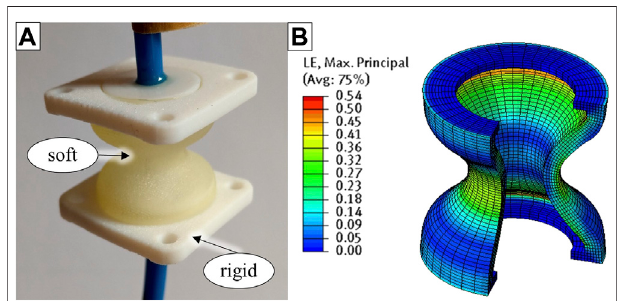
FIGURE8| Structuralsimulationofabellowsrelaxation experiment. The inkjet-printed specimens consist of rigid top and bottom fl anges and a soft bellows structure (A) . In the corresponding FE model, the soft bellows structure is modeled under consideration of its rotational symmetry, and fl anges are represented by appropriate boundary conditions (B) .